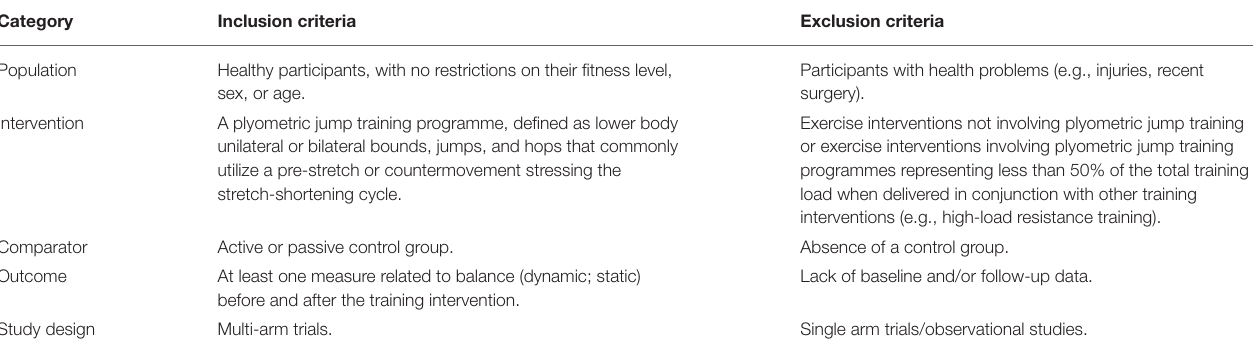
TABLE 1 | Selection criteria used in the meta-analysis.